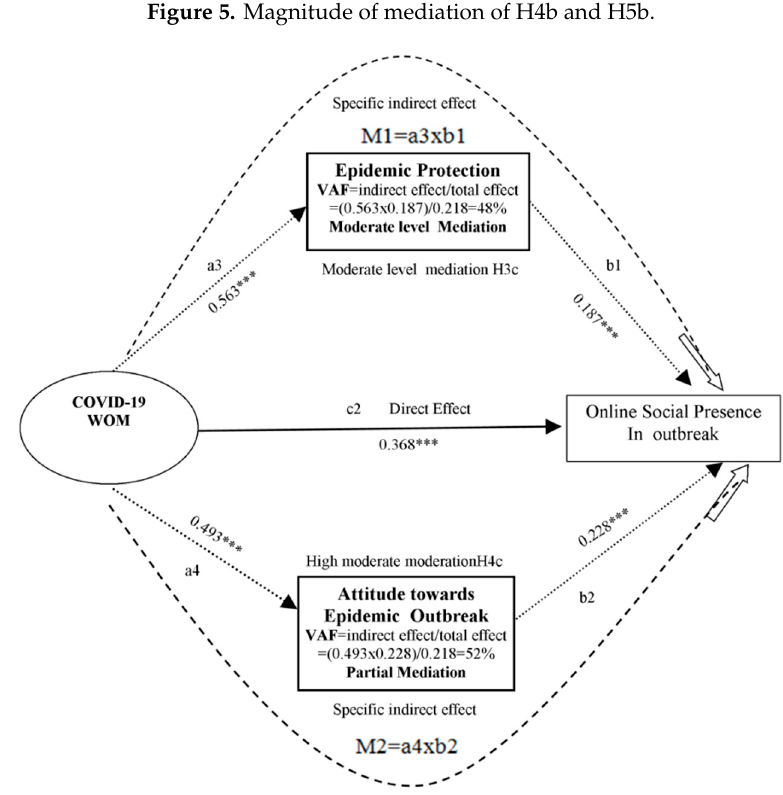
Figure 6. Magnitude of mediation of H3c and Figure6 Magnitude of mediation of H3c and H4c Figure6 Magnitude of mediation of H3c and H4c